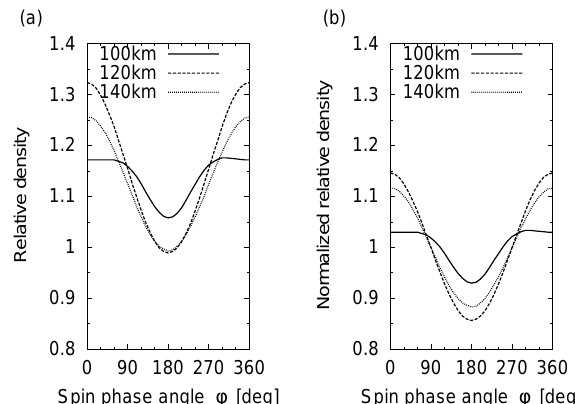
Fig. 8. Relative density changes for the observation between the 100–105-km altitudes and the DSMC results for 100 and 105km. The vertical axis corresponds to the measured/smoothed value for the observation and the normalized relative density for the DSMC